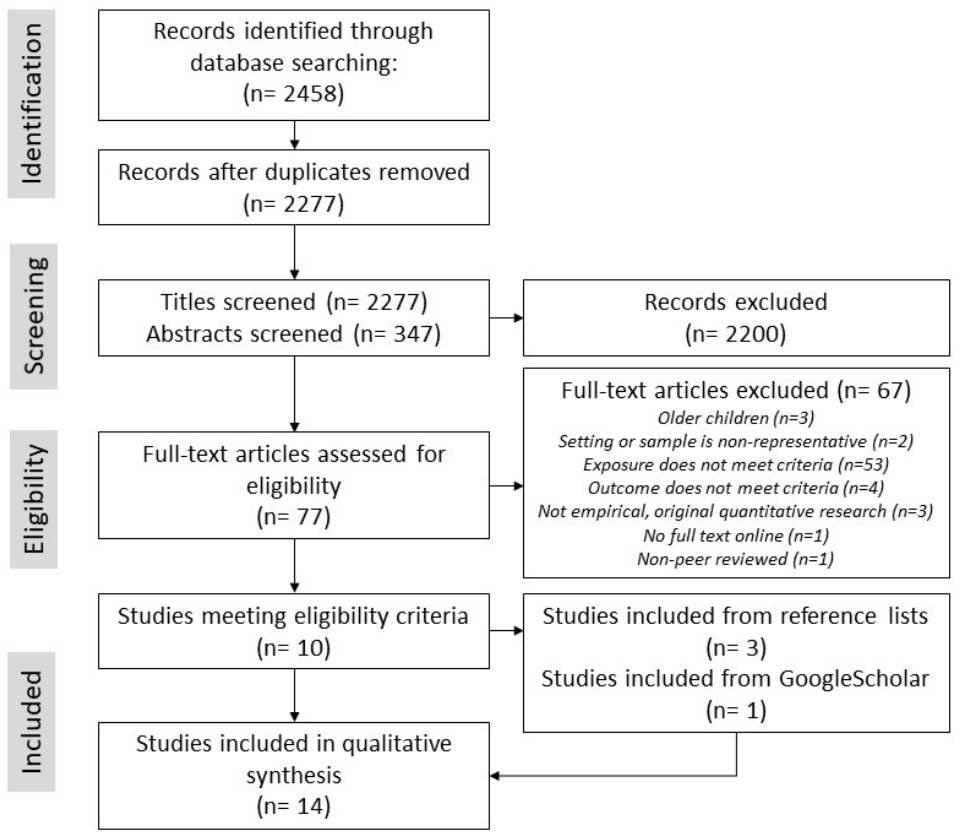
Figure 2. Preferred Reporting Items for Systematic Review and Meta-Analysis (PRISMA) flow diagram describing the procedure carried out to identify and assess articles for inclusion in the